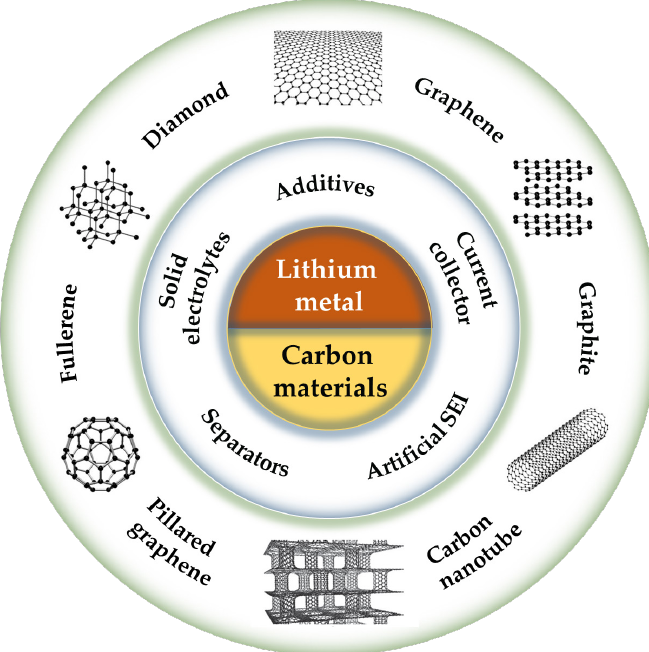
Figure 1. Various strategies applied by carbon materials in lithium metal batteries.